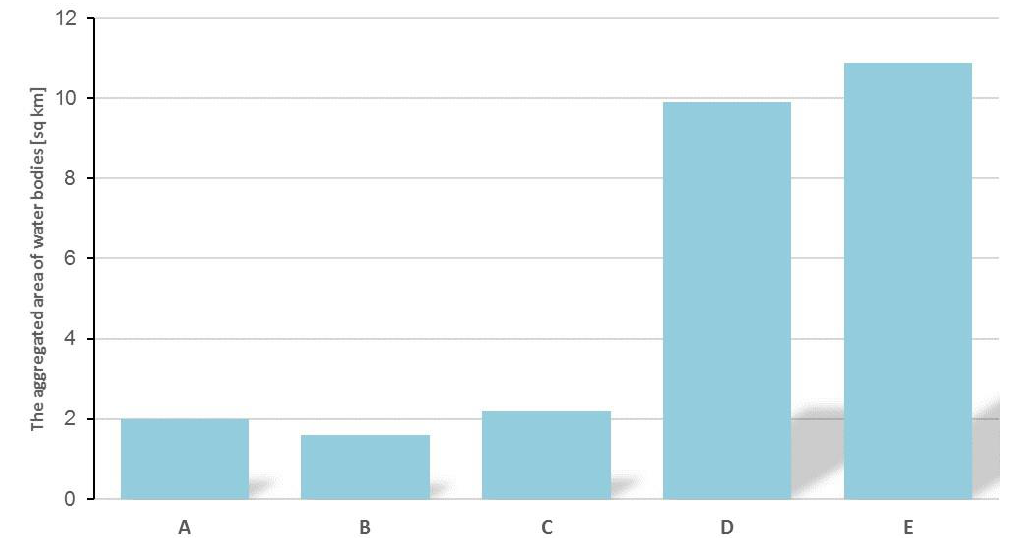
Fig. 7. The aggregated area of water bodies provided for specific time periods: A – the beginning of the 19 th century, B – the end of the 19 th century, C – the beginning of the 20 th century, D the end of the 20 th century, E ¬ the beginning of the 21 st century (own study based on